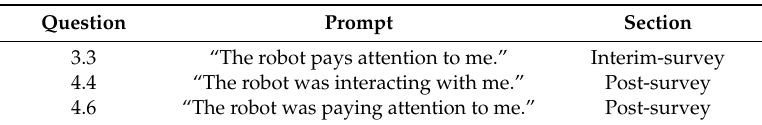
Table 7. Summary of survey results focusing on robot autonomy, comparing how individual responses changed after the imitation session.